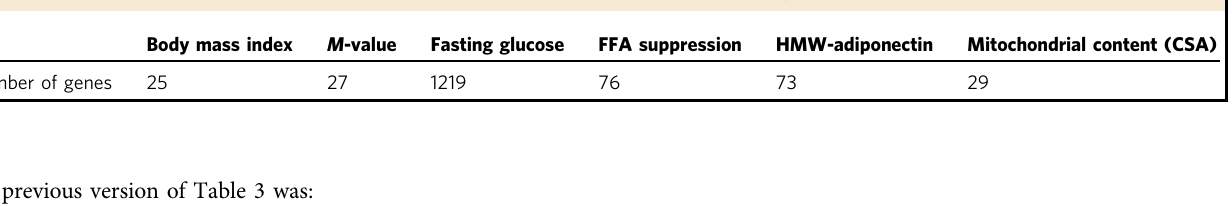
Table 2 Pearson correlations between gene expression levels and indicated clinical parameters.